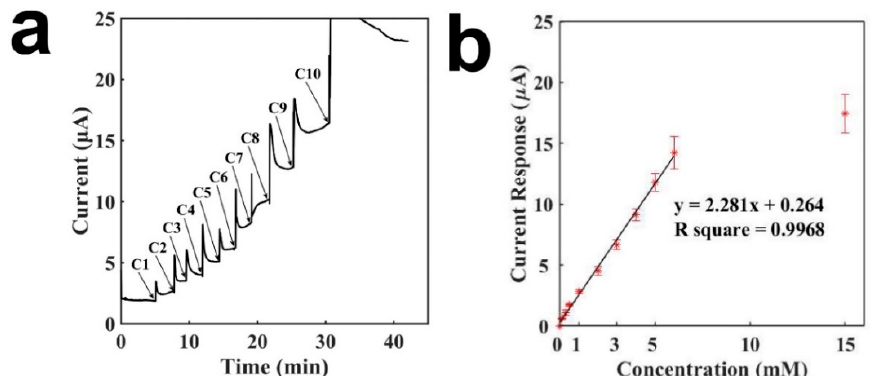
Figure 4. Characterization of the tongue-depressor amperometric sensors for glucose (phosphate bu ff er: 90 µ L, droplet of glucose of di ff erent concentrations: 10 µ L). ( a ) Current-versus-time curve for the detection of glucose; ( b ) Calibration curve for the detection of glucose. C1: 0.1 mM, C2: 0.2 mM, C3: 0.2 mM, C4: 0.5 mM, C5: 1 mM, C6: 1 mM, C7: 1 mM, C8: 1 mM, C9: 1mM, C10: 9 mM.